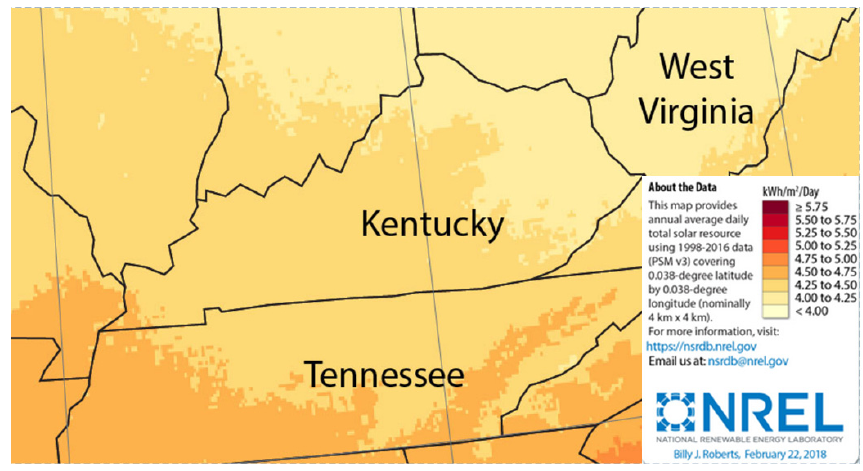
Figure 7. Solar irradiation data from NREL displayed on map for various regions of Kentucky .